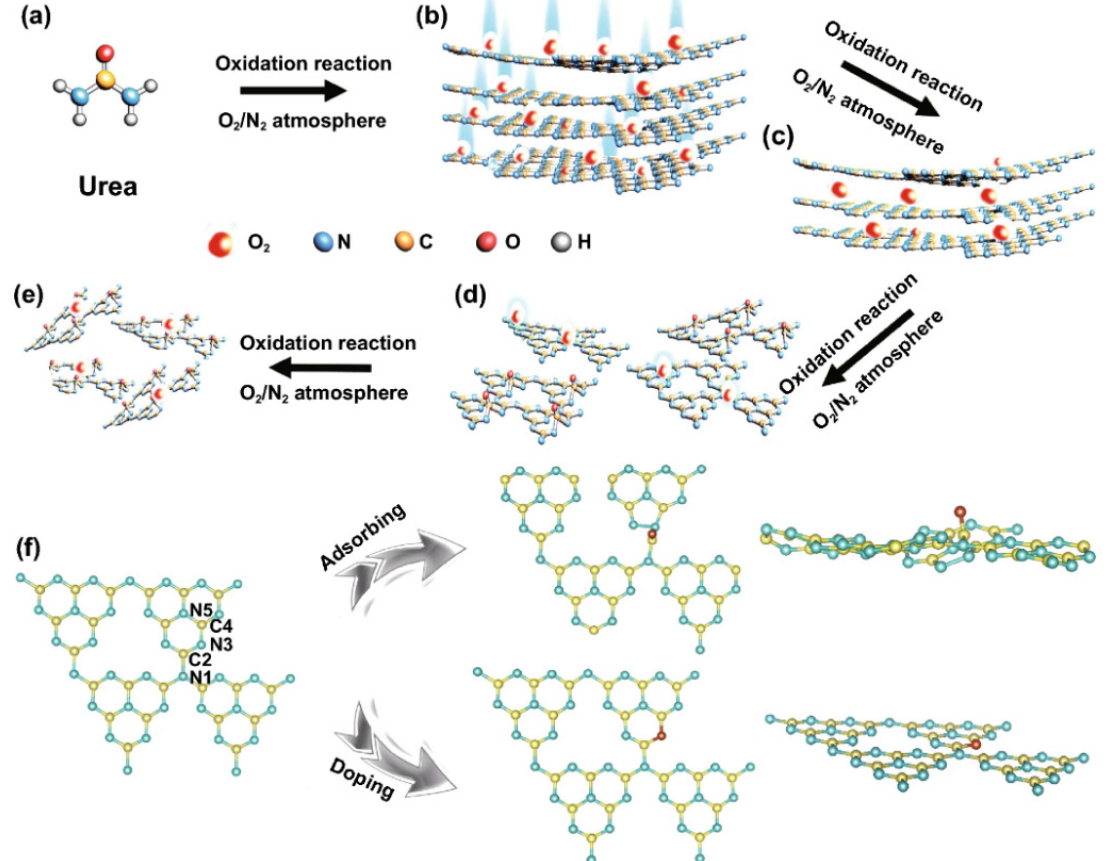
Figure 8. The formation process and mechanism of OCN photocatalysts. ( a – e ) synthesis of OCN photocatalysts. ( f ) DFT simulations. Reprinted with permission from Ref. [132]. 2021, Springer Nature